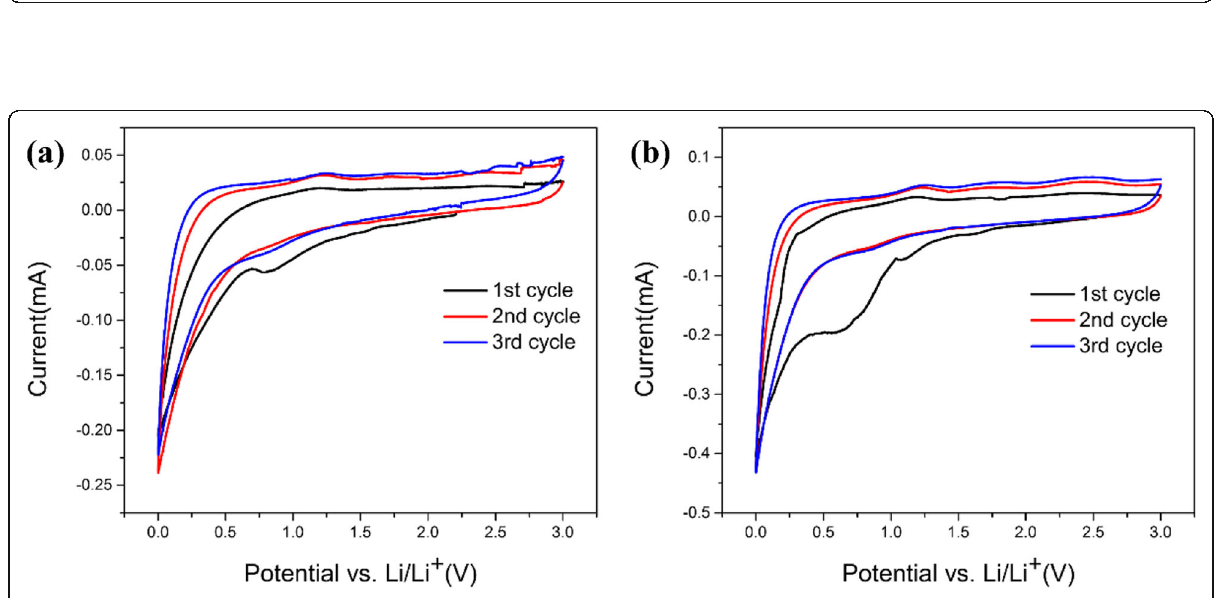
Fig. 6 a Cycle performance curves. b Charge-discharge voltage curves of AC-500. c Charge-discharge voltage curves of CAC-500. d Rate performance of AC-500 and